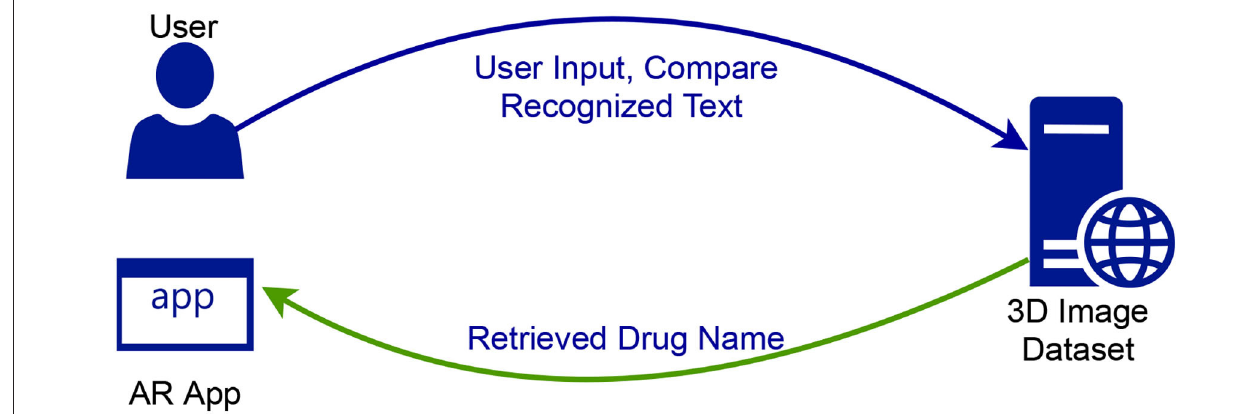
FIGURE 1 | Transaction flow system mode.